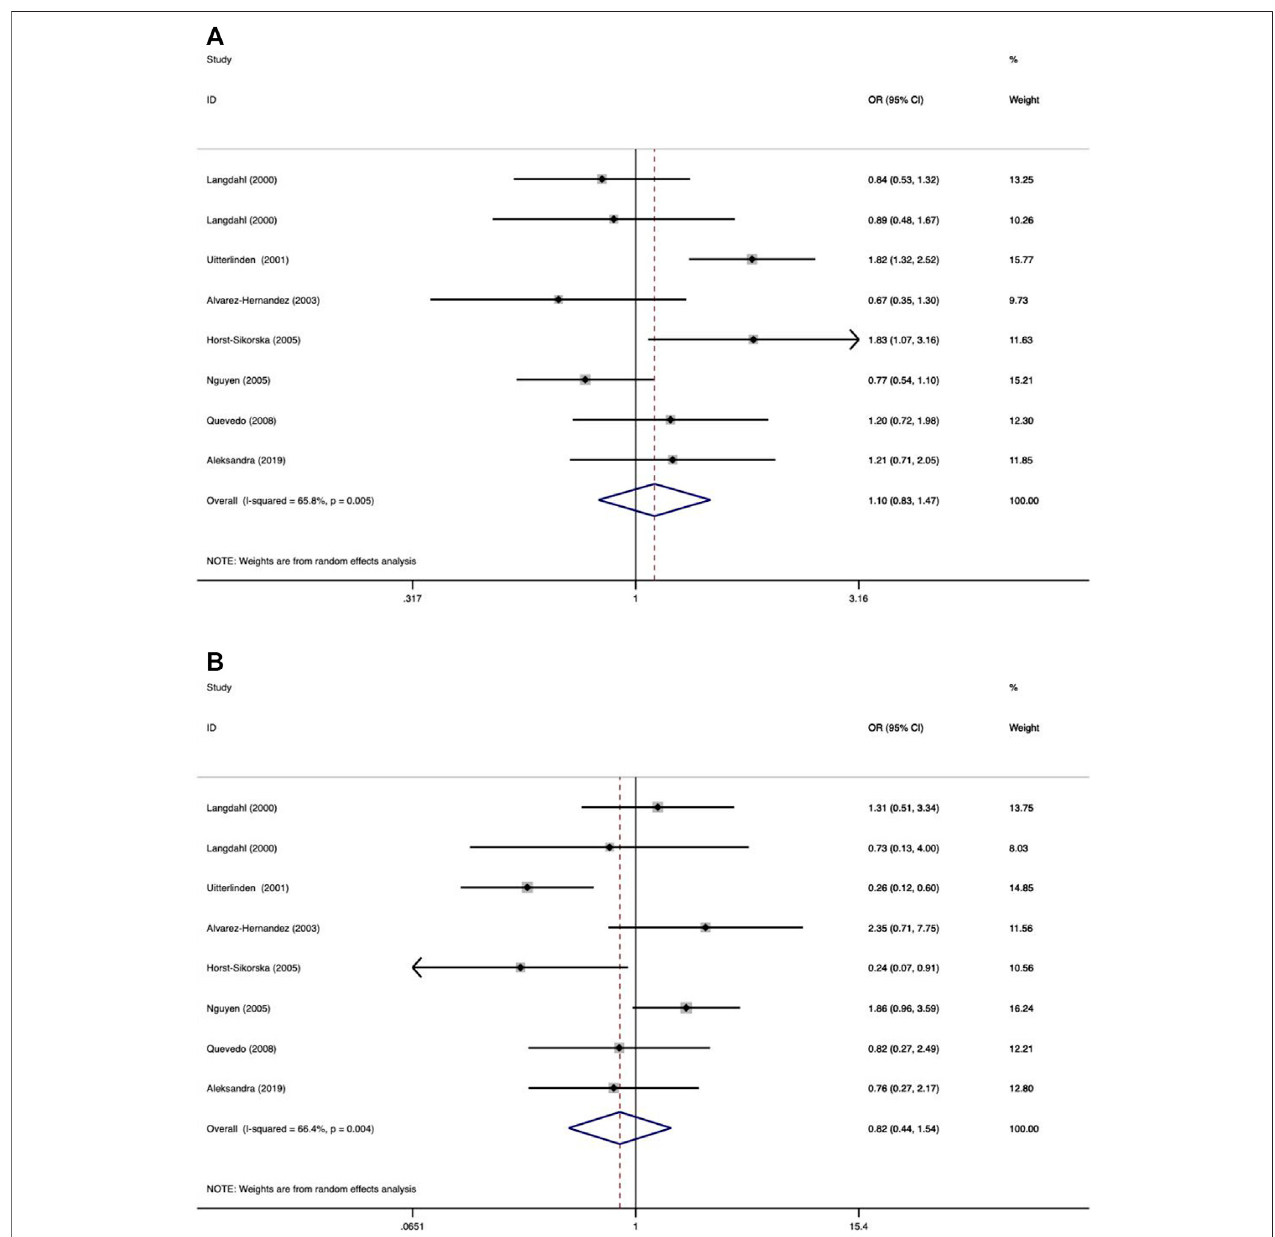
FIGURE4| Forest plotsofallselected studiesontheassociationbetween VDRTaqlpolymorphismandtheriskofosteoporoticfractureindifferentraces [ (A) allele model, (B) additive model, (C) dominant model, and (D) recessive model].